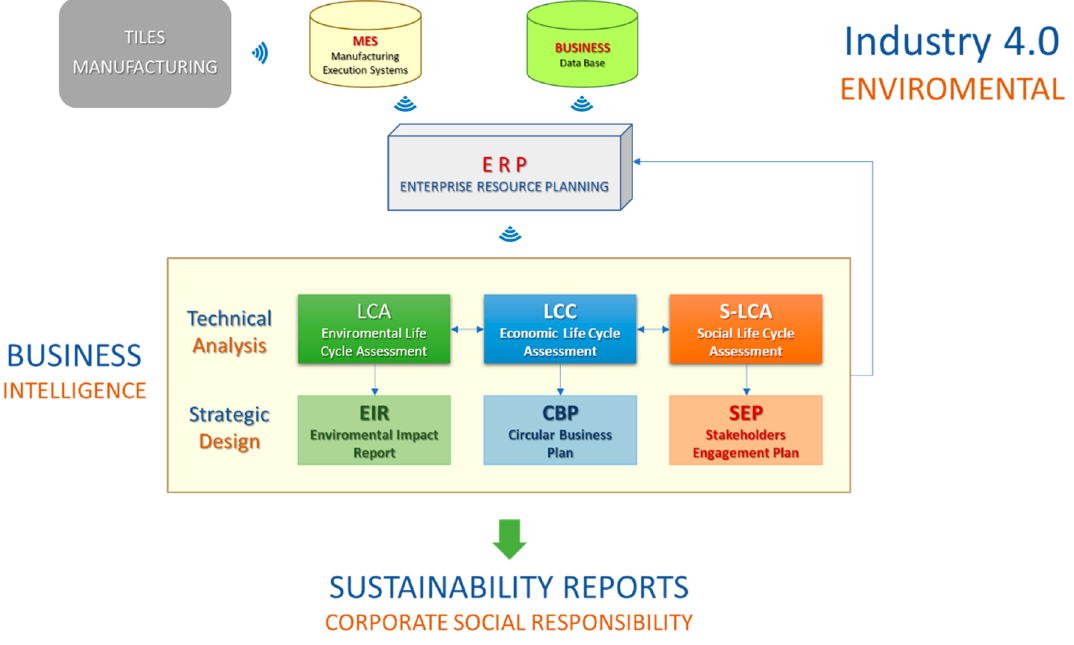
Figure 5. Assessing ceramic manufacturing data in an Industry 4.0 environment. Table 1. Enterprise Resource Planning (ERP) data integration